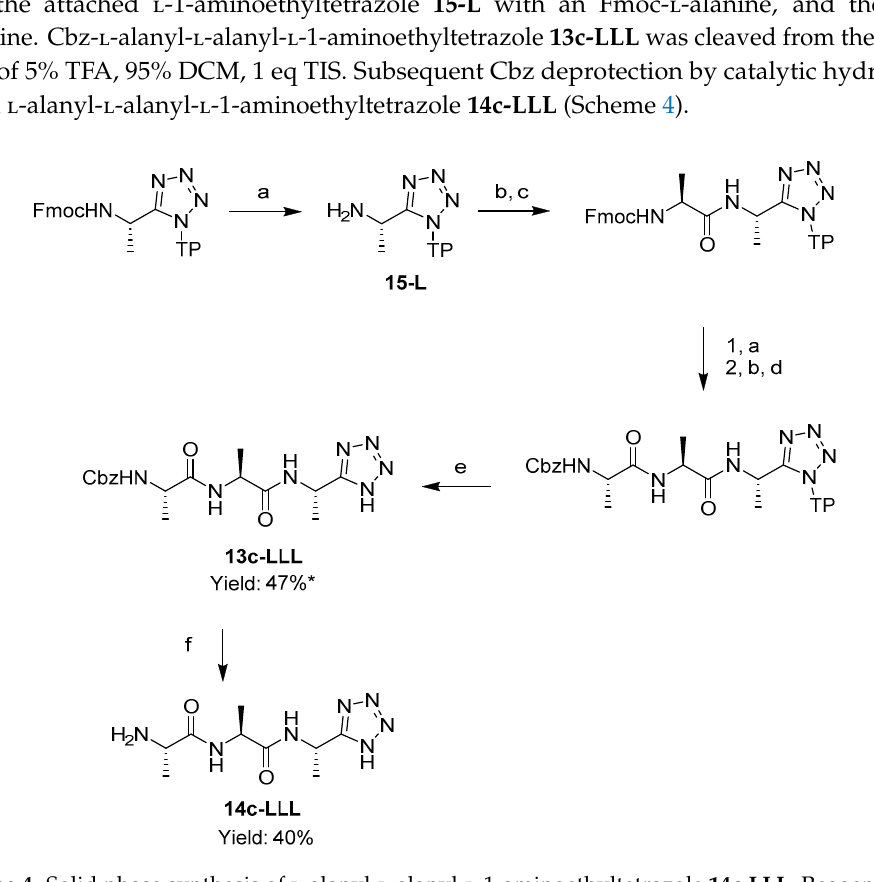
Table 1. Yields and conditions for Scheme 3: Abbreviations: p: the cleaved mixture was triturated and washed with petroleum ether 40–60 °C before yield and impurity calculation; n.o.: not observed; a: the loading was possibly inhomogeneous, and might have been washed with an insufficient amount of piperidine in